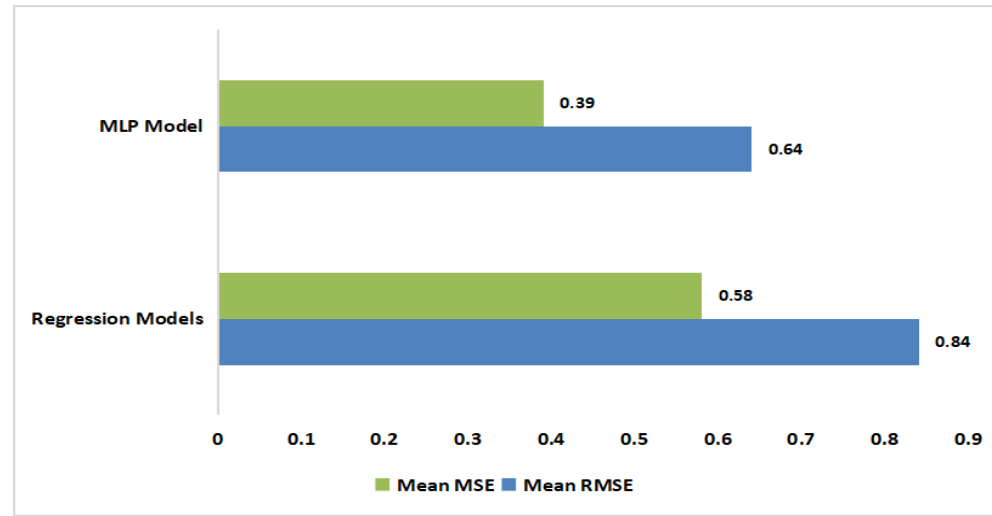
Figure 8. Error rate analysis with MLP and other regressor models using the CBECS dataset.